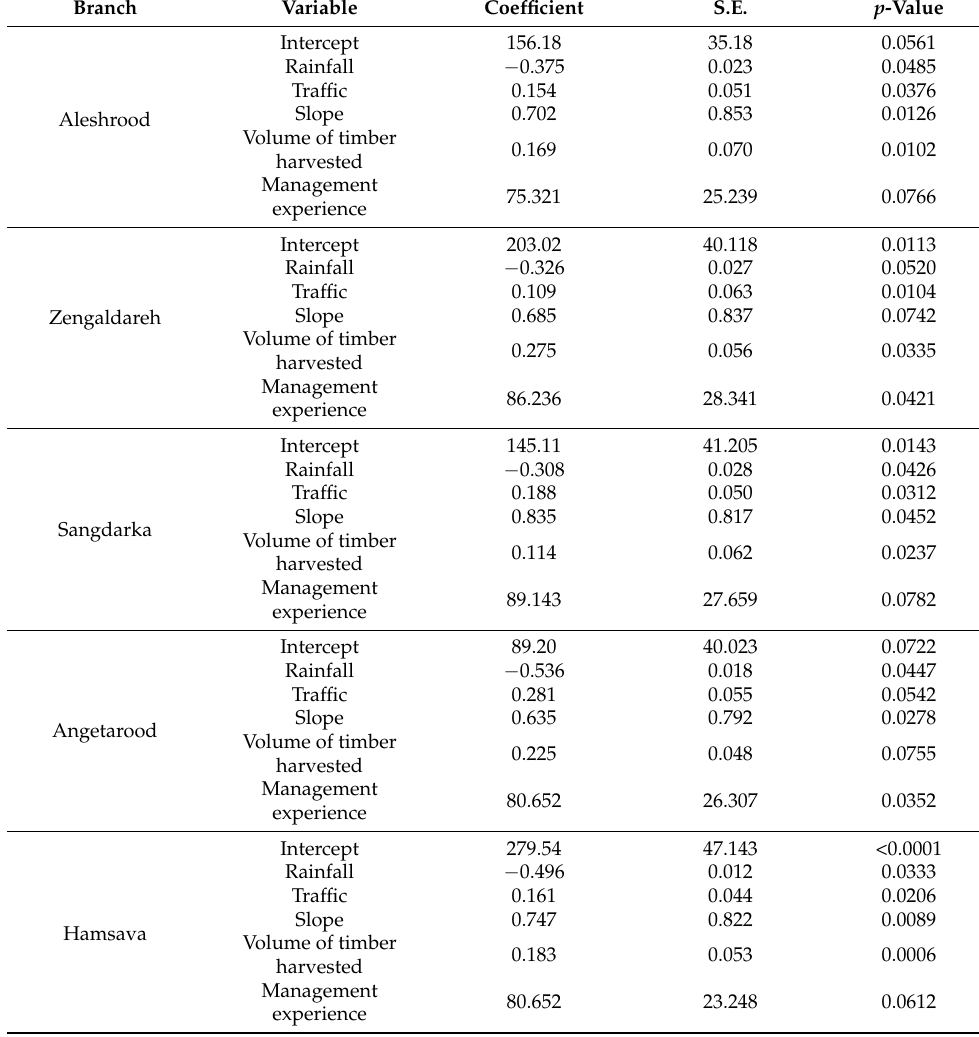
Figure 4. FRPCI in All Districts of Forest Road Network define sections and FRPCI values . Table 7. Result of Regression